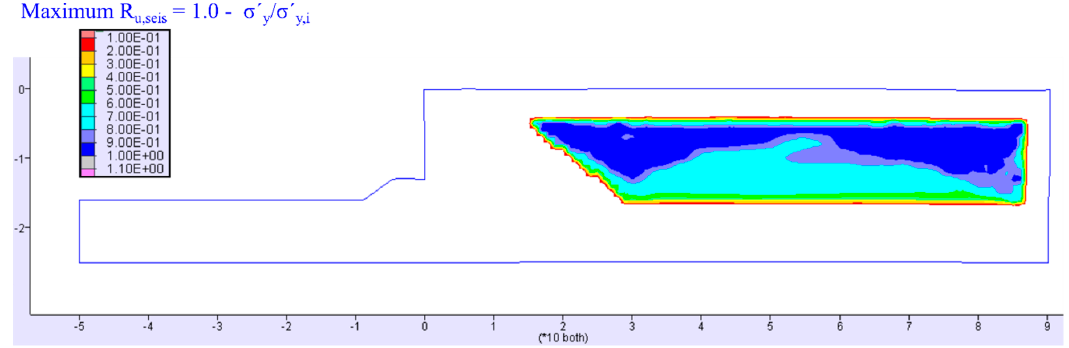
Figure 18. Maximum excess pore water pressure ratio (R u,seis = 1.0 − σ´ y / σ´ y,i ) contours at the end of shaking (dimension unit in meters).